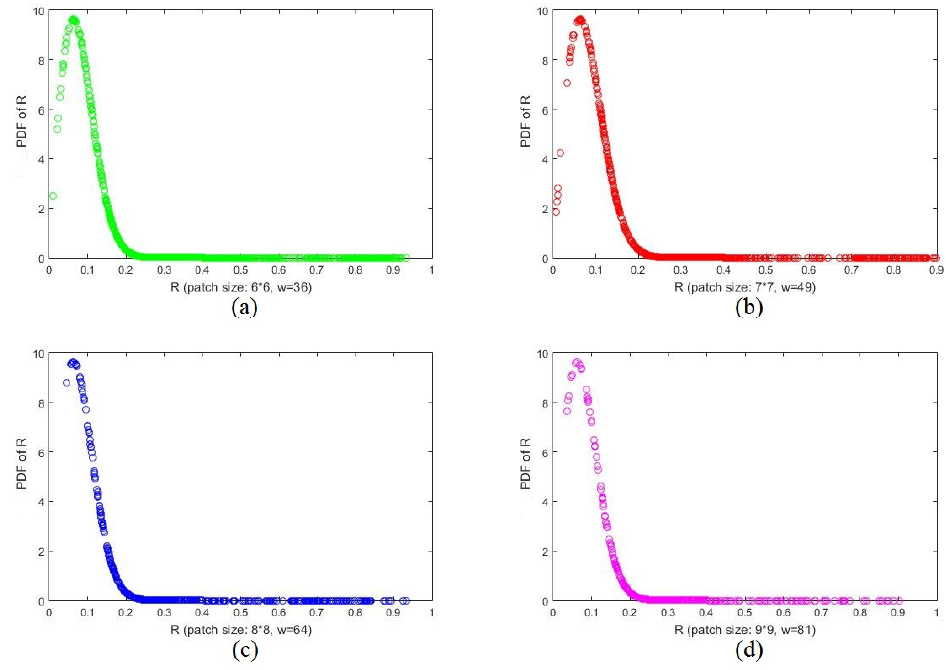
Figure 3. PDFs of Dominant Measure R, (a) shows PDF of R in 6*6 patch size, (b) shows PDF of R in